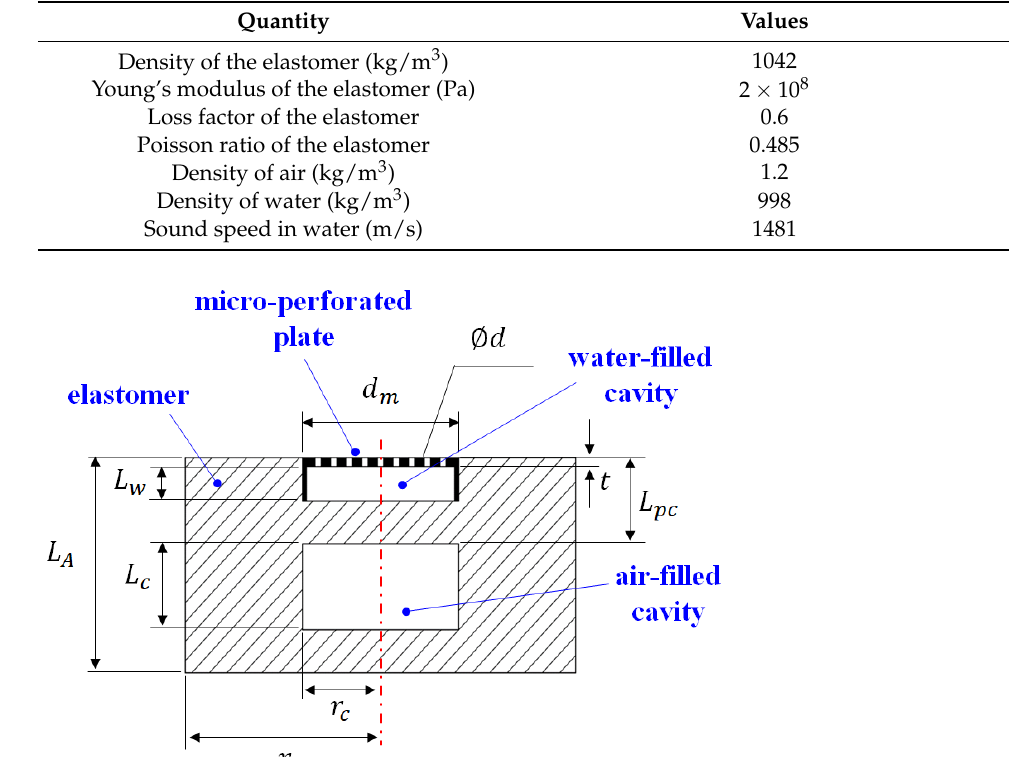
Table 1. Parameters considered for the substrate of the developed metastructure [8].